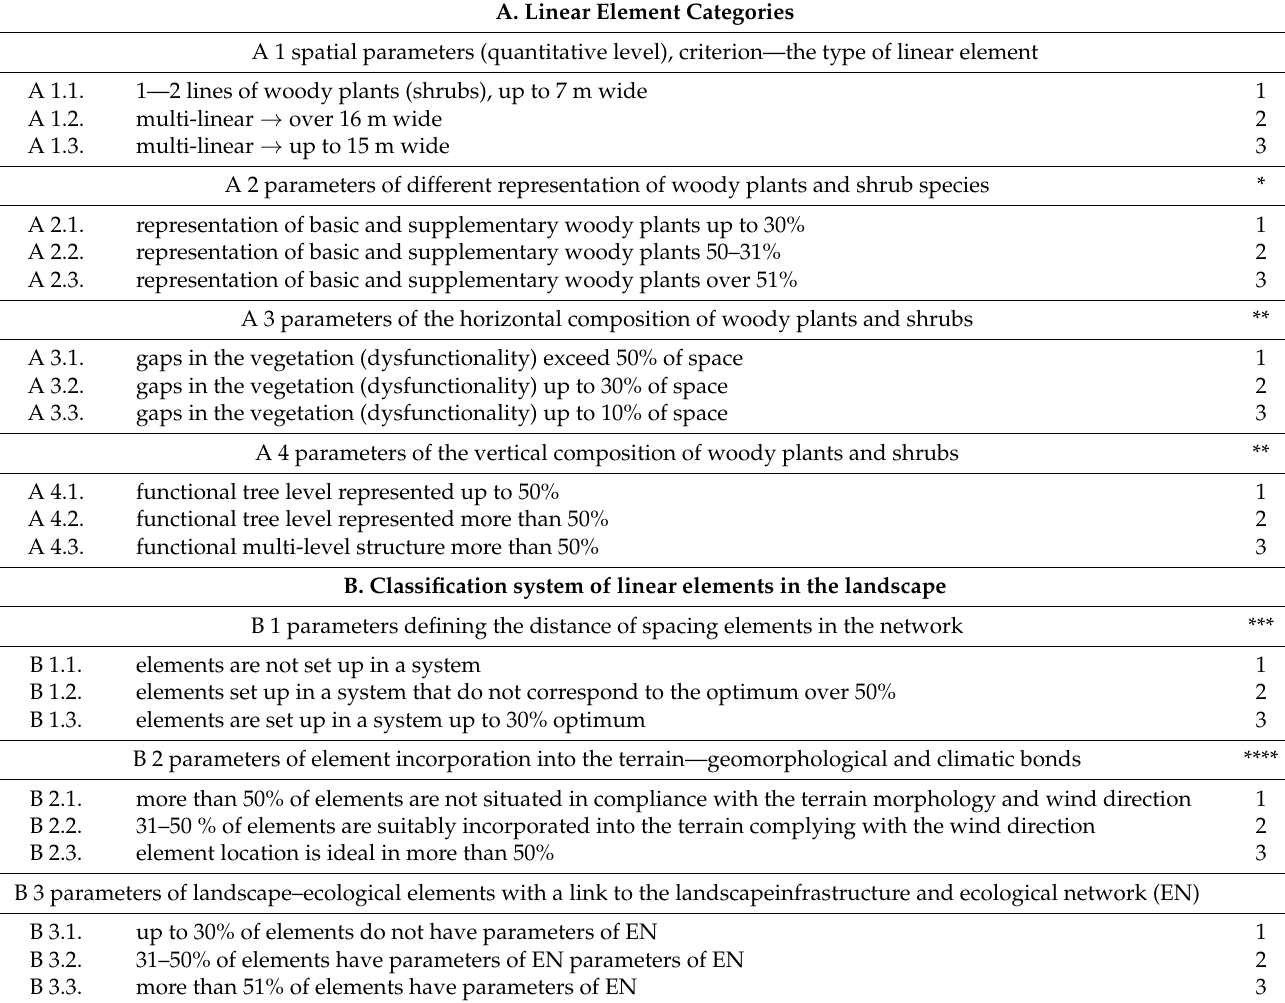
Table 1. Point scoring of linear element